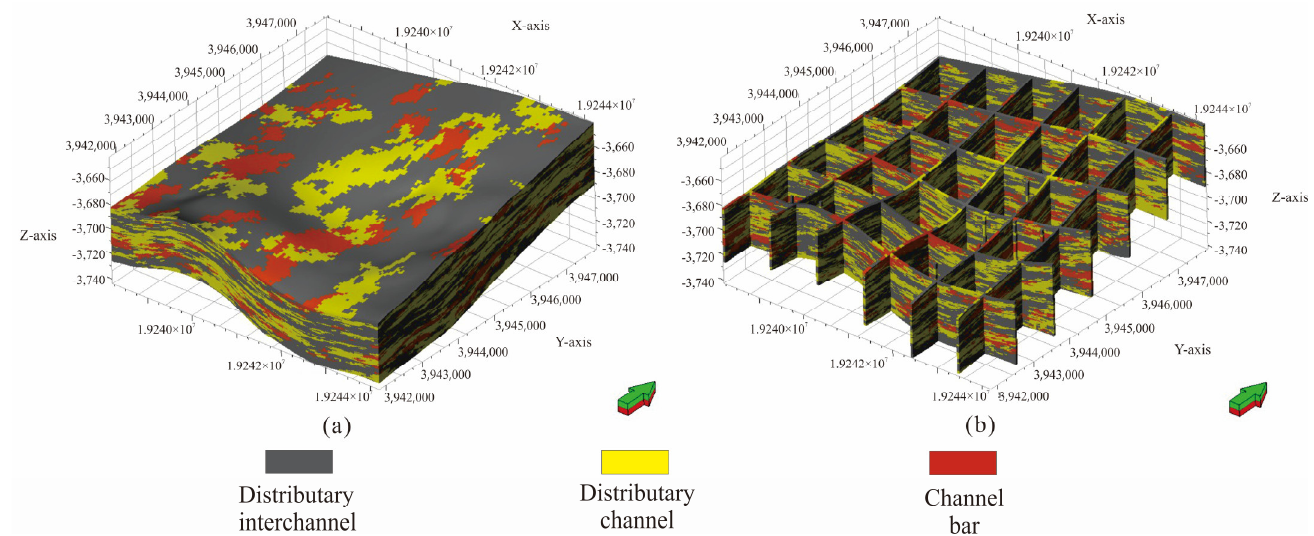
Figure 9. Simulation result of SIS. ( a ) 3D model; ( b ) grid model.